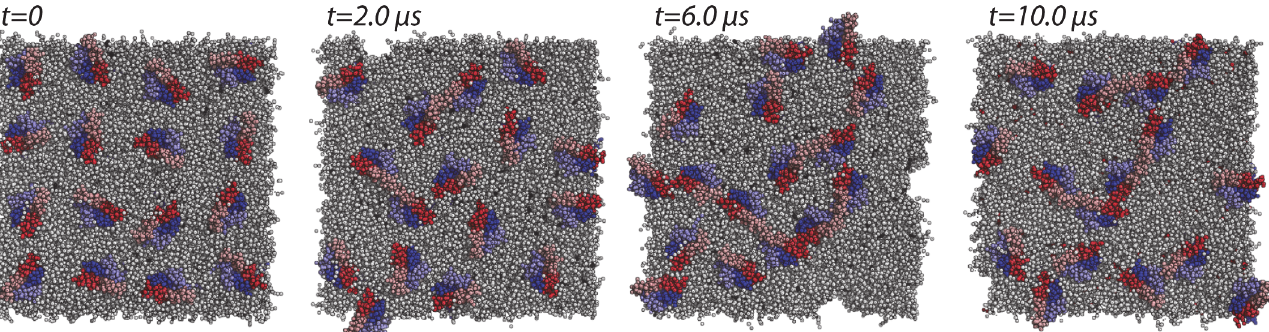
Fig 1. An example of OR setup at different simulation times. Location of the 16 simulated receptor molecules in one of the five runs executed for the κ -OR system (run #1), at different simulation times (specifically: 0, 2, 6, and 10 μ s)